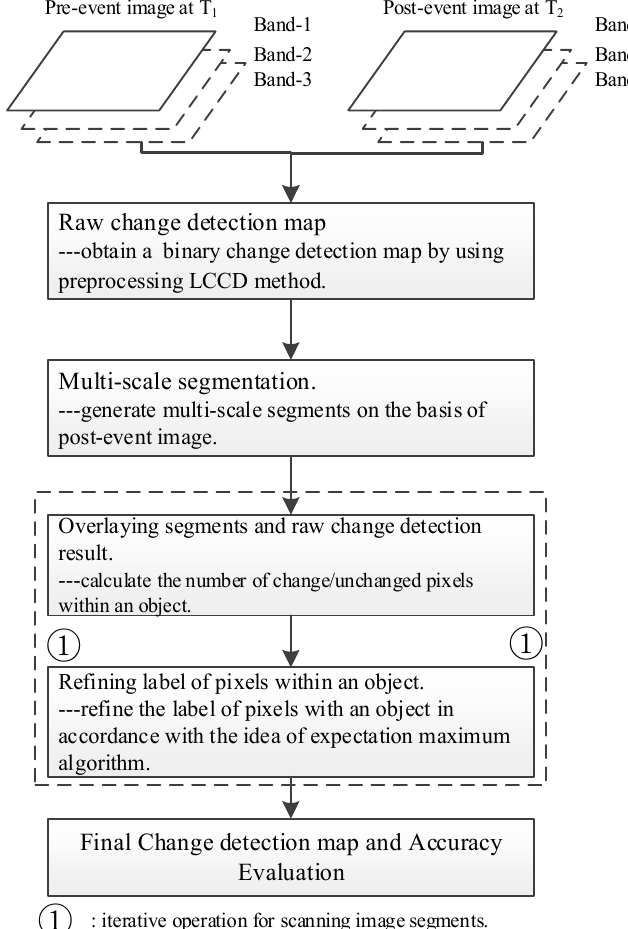
Figure 1. General scheme of the proposed object-based expectation maximization (OBEM) post-processing change detection approach.